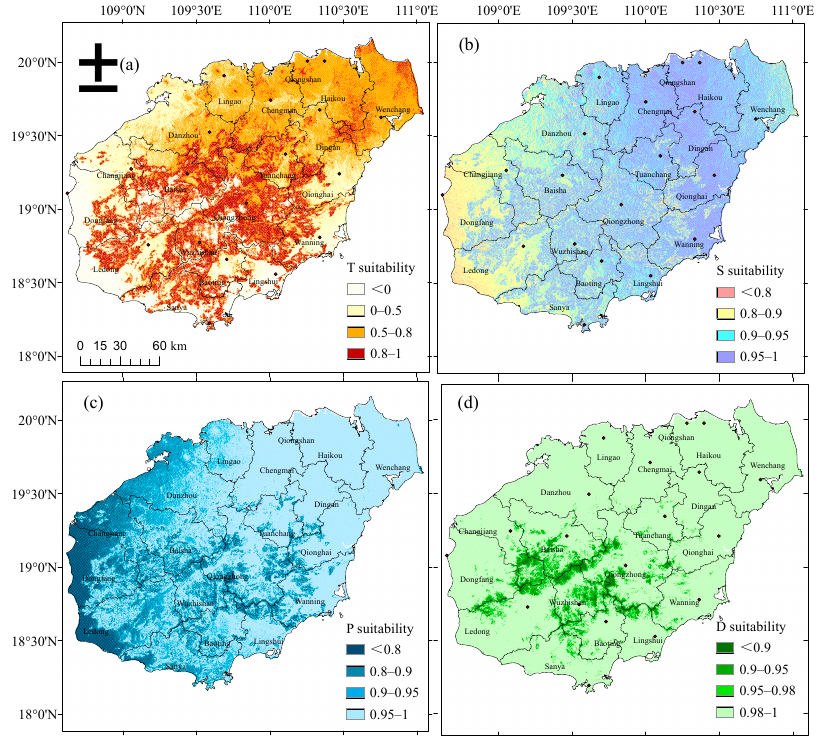
Figure 2. The climate suitability of green orange total results of the main climatic sub-models showing the spatial distribution of: ( a ) annual average temperature suitability index sub-model results, ( b ) annual actual sunshine suitability index sub-model results, ( c ) annual precipitation suitability index sub-model results, ( d ) annual accumulated temperature ≥ 10 ◦ C suitability index sub-model